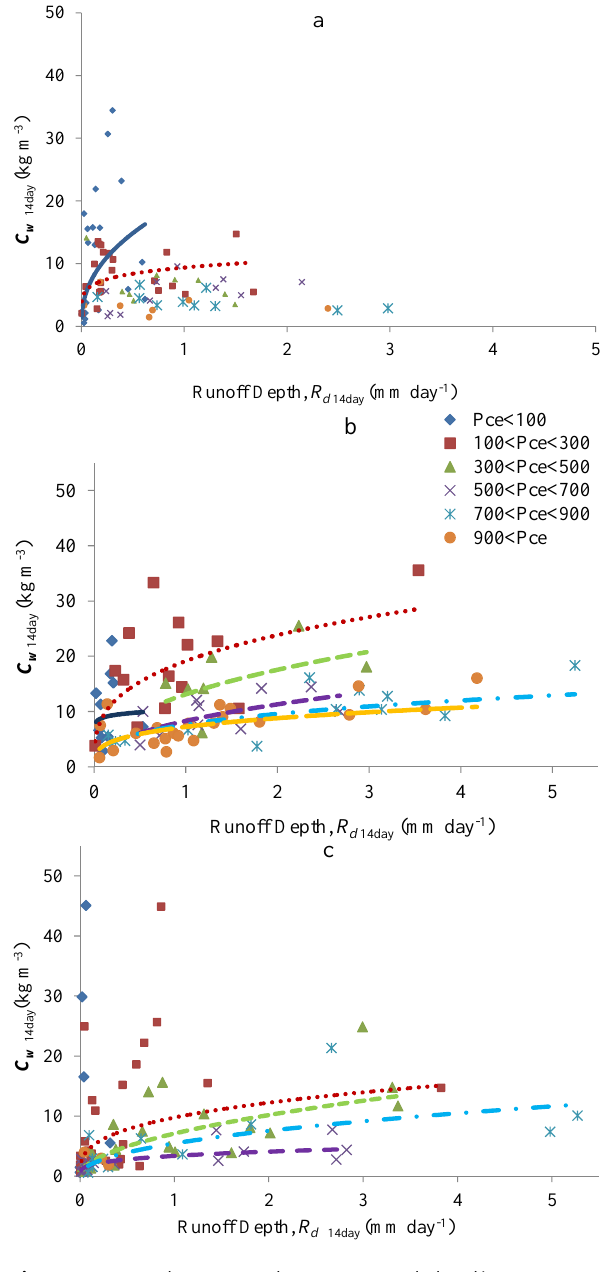
Fig. 4. Fourteen day avaraged storm suspended sediment concentration ( C w in kg m -3 ; y-axis) 2 Fig. 4. Fourteen-day averaged storm suspended sediment concen- and runoff depth ( R d in mm day -1 ; x-axis) for (a) Andit Tid (b) Anjeni (c) Maybar. The 3 tration ( C w in kgm − 3 ; y-axis) and runoff depth ( R d in mm day − 1 ; regression lines have the same color as the symbols and are displayed for periods with 12 or 4 x-axis) for (a) Andit Tid, (b) Anjeni, and (c) Maybar. The regression more observations. The regression coefficients and R 2 values are tabulated in Table 2 5 lines have the same color as the symbols. The regression coefficients 6 and R 2 values are tabulated in Table